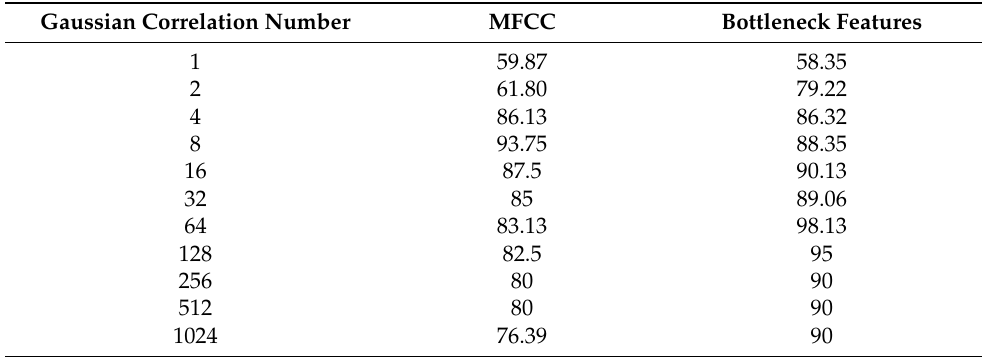
Table 2. Comparison of recognition results between MFCC and bottleneck features